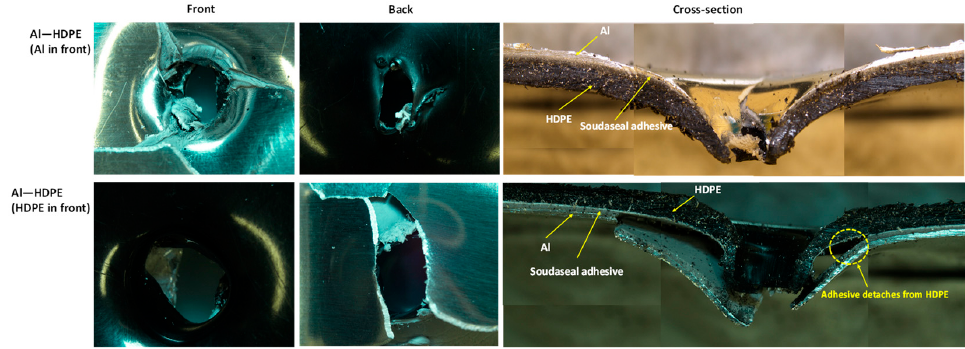
Figure 9. Failure modes of bilayer laminates under the conical indenter.